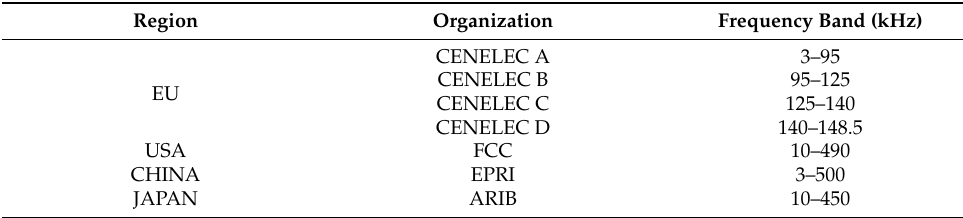
Table 1. Summary of available NB-PLC frequency bands in different regions of the world.